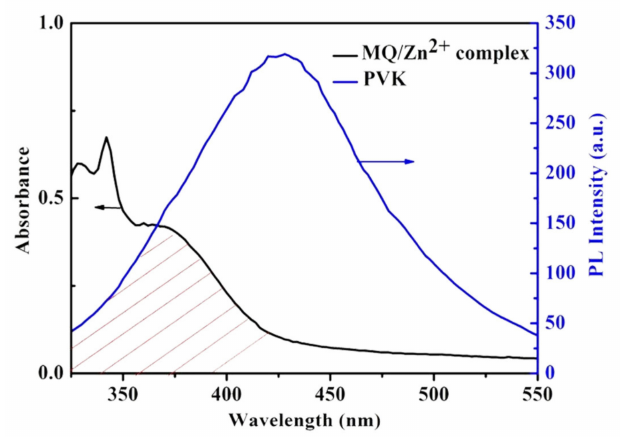
Figure 8. Spectral overlap of absorption ( black line ) of MQ / Zn 2 + complex and emission spectrum ( blue line ) of PVK.